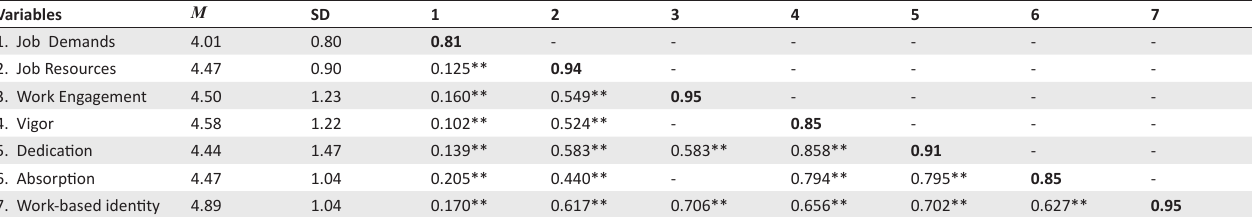
TABLE 2: Mean, Standard Deviations, Internal Consistencies (Cronbach α’s on the Diagonal), and Correlations amongst the Variables ( N = 2429). Variables M